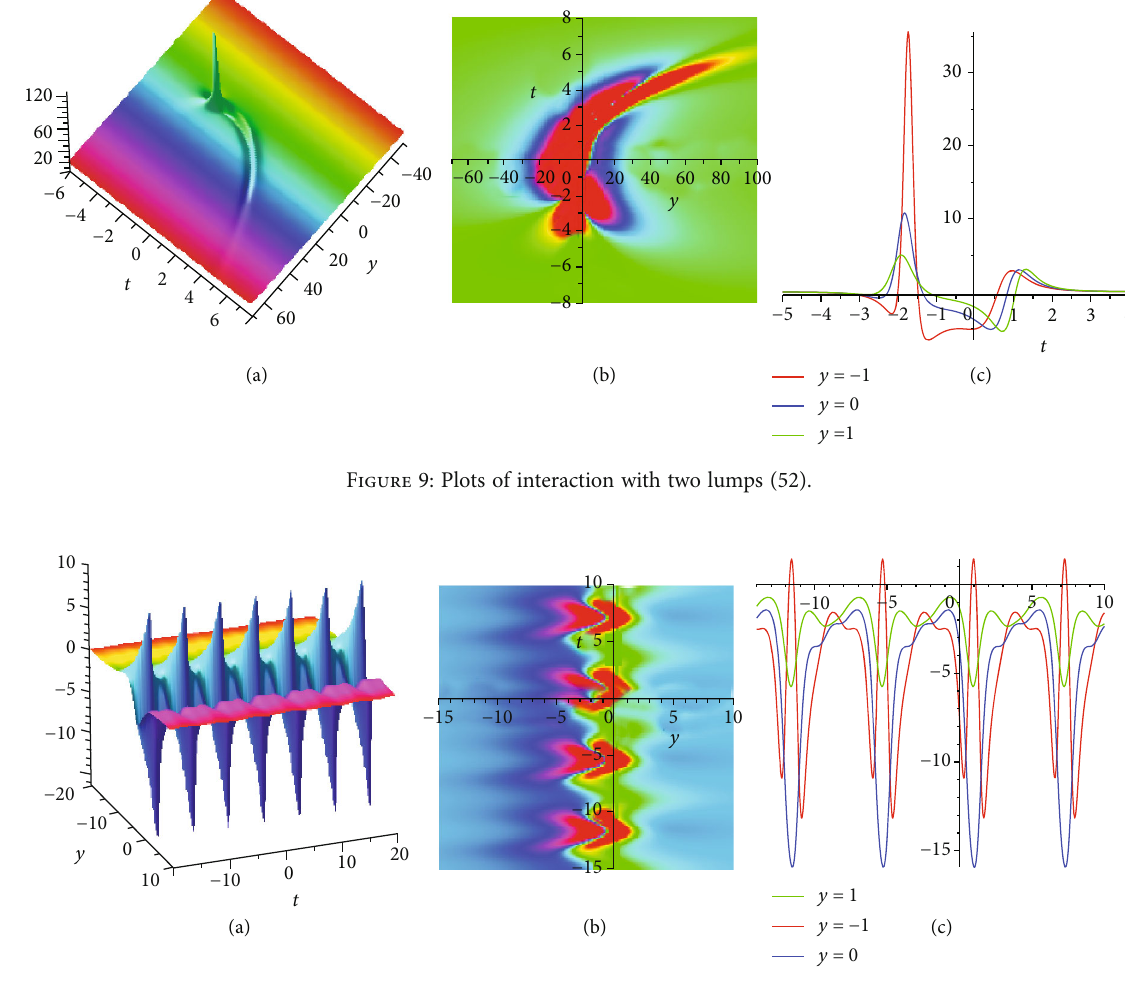
Figure 10: Plots of interaction with two lumps (52).